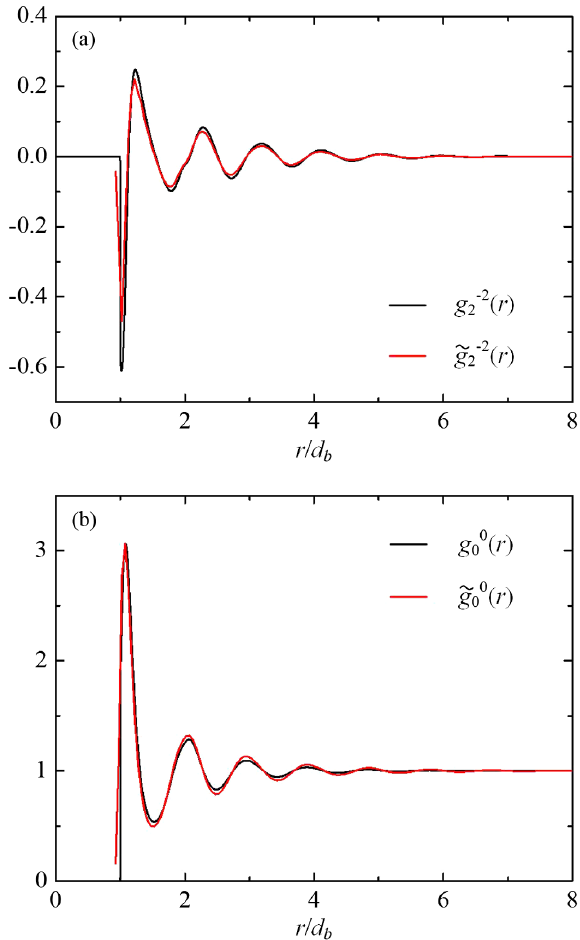
FIG. 15. (a) Comparison between ˜ g − 2 2 ð r Þ and g − 2 2 ð r Þ . (b) Com- parison between ˜ g 0 0 ð r Þ and g 0 0 ð r Þ . The simulation condition is ϕ ¼ 45% , Pe ¼ 0 . 75